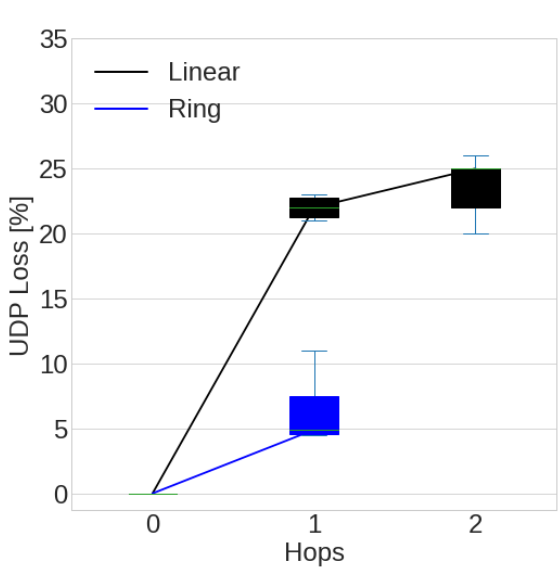
Figure 15. POWDER lab UDP loss. 3.